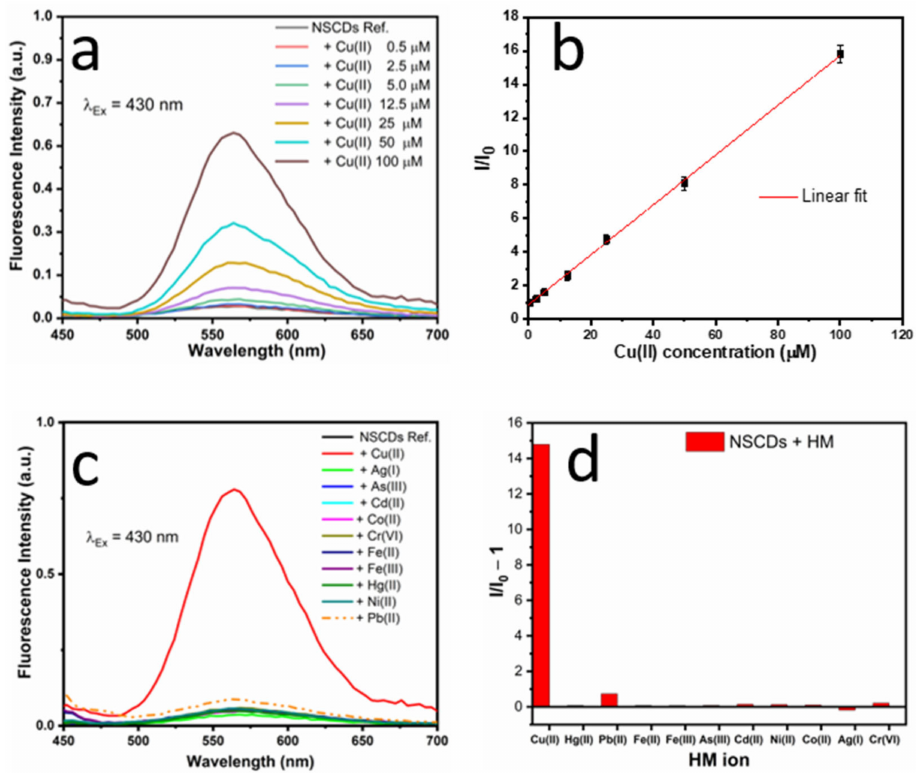
Figure 6. ( a ) Emission spectra of NSCDs in the presence of Cu(II) at different concentrations. ( b ) calibration plot showing the fluorescence enhancement intensity vs. the Cu(II) concentration over the range 0–100 µ M; ( c ) emission spectra of NSCDs in the presence of different metal ions at a concentration of 100 µ M; ( d ) selectivity of fluorescence response of